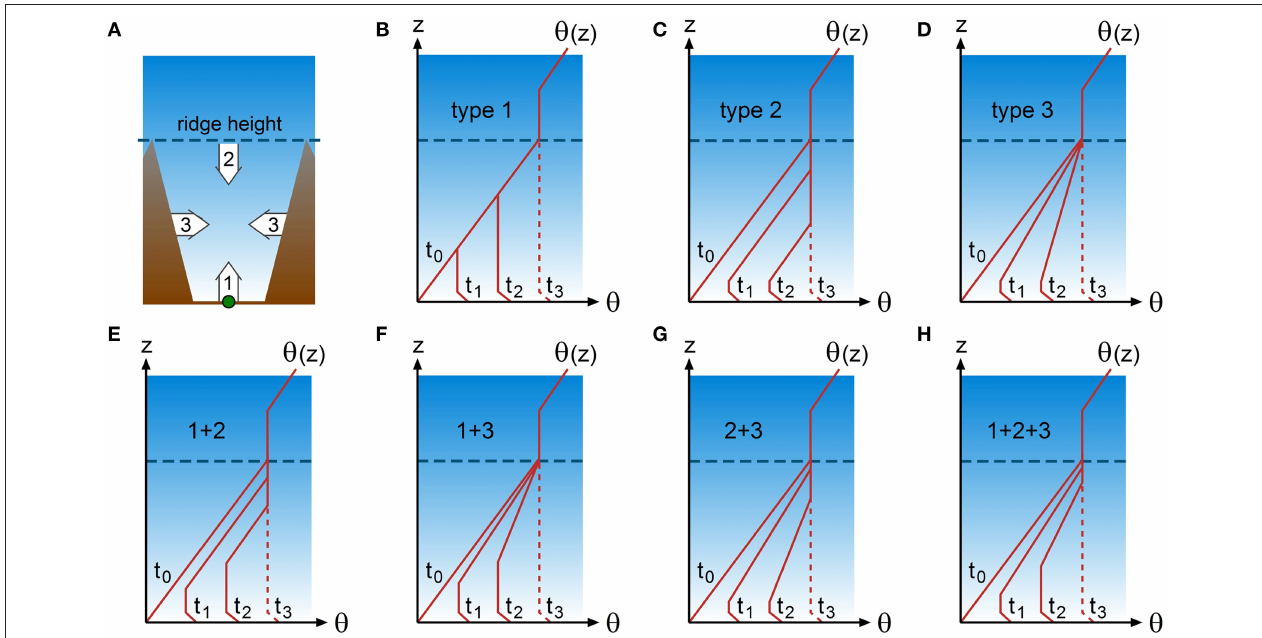
FIGURE 5 | Conceptual models of CBL development in the center of a valley. The location of the idealized vertical profiles of potential temperature θ (z) at times t 0 –t 3 is shown by the green dot in (A) . (B–D) in the top row show three basic types of CBL development, while (E–H) in the bottom row show four combinations (mixed types) of the three basic types. The main direction of heat supply and erosion of the valley inversion for the three basic types are illustrated by numbered arrows in (A) : arrow 1: turbulent heat flux from the valley floor (type 1); arrow 2: subsiding valley inversion (type 2); and arrow 3: heating from valley side walls by slope wind recirculation (type 3). The dashed line at t 3 indicates that a well-mixed potential temperature profile throughout the entire valley atmosphere does not necessarily occur.